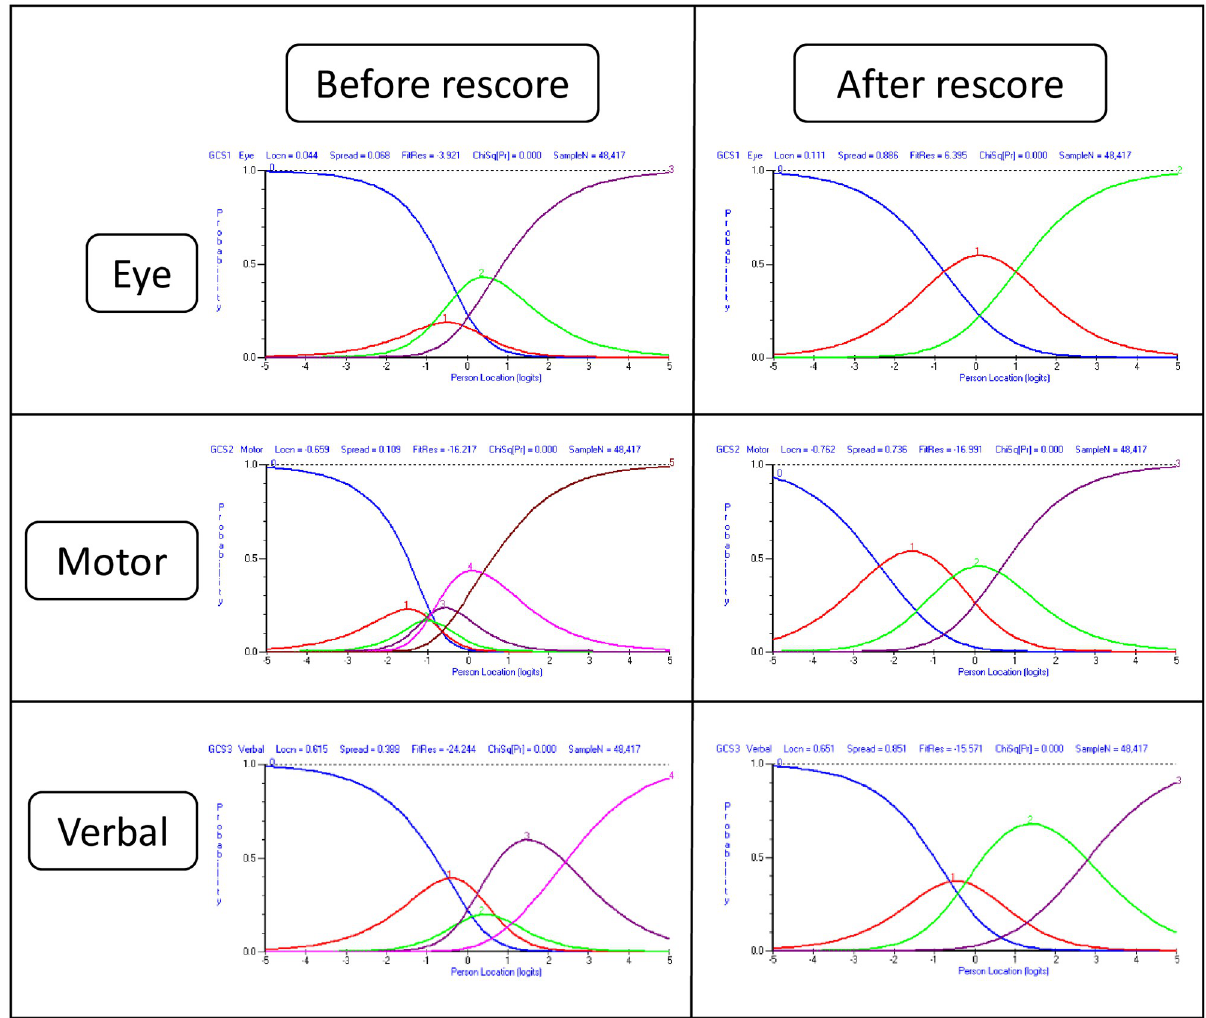
Fig 1. GCS response category probability distribution curves (i.e., Rasch-Andrich threshold plots), pre- and post-rescore (corresponds to sample 1a and 1b). Each plot displays person location on the ‘consciousness’ scale on the x-axis, with a higher score (to the right) representing a higher/better level. The curves represent implied probability distributions of the likelihood of a person responding in each of the response categories of the items, given their location on the scale. Prior to rescoring, the response categories were dysfunctional for all items. Post-rescore, a functional scoring system is observed.